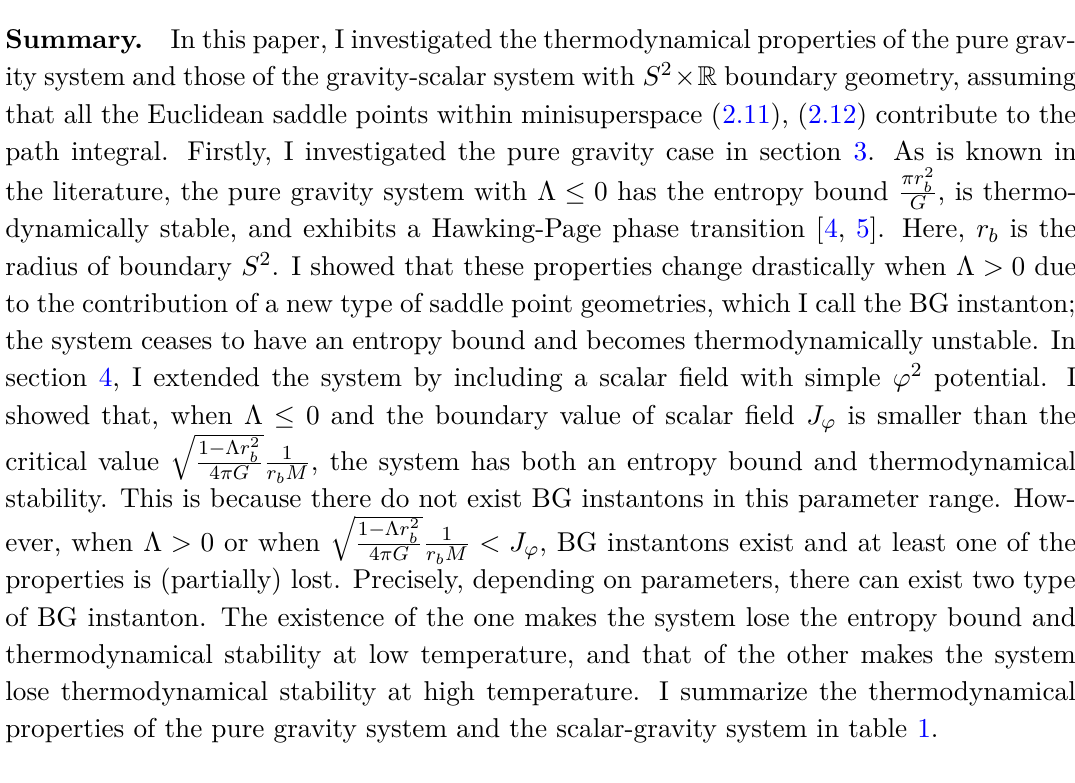
Figure 22 . Qualitative behaviors of entropies (left panel) and free energies (right panel) of BG instanton (and Euclidean soliton) when 0 < Λ ≤ 1 thermodynamically stable branches are 4A and 4E; branches 4D’ and 4H are unstable. ( Left ) The dominant saddle is 4D’. There is no entropy bound. ( Right ) Although the dominant saddles are the thermodynamically stable branches 4A and 4E, they suffer from quantum tunneling instability. Therefore, the system is thermodynamically